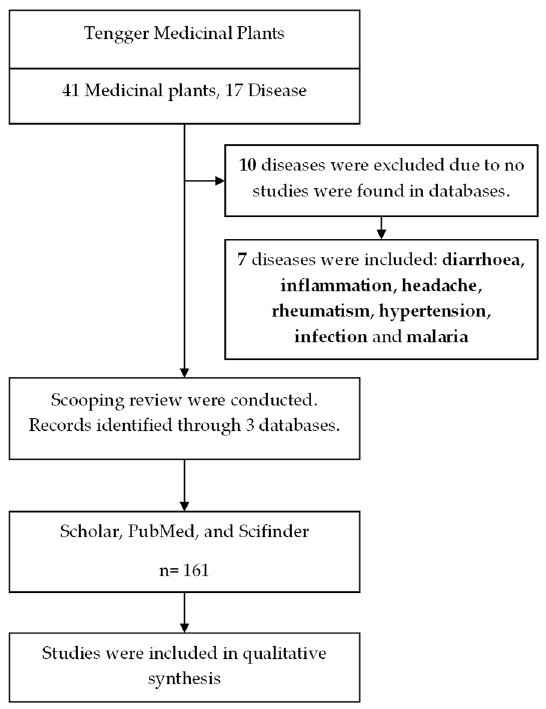
Figure 2. Flow chart of our approach to scoping literature is presented here.